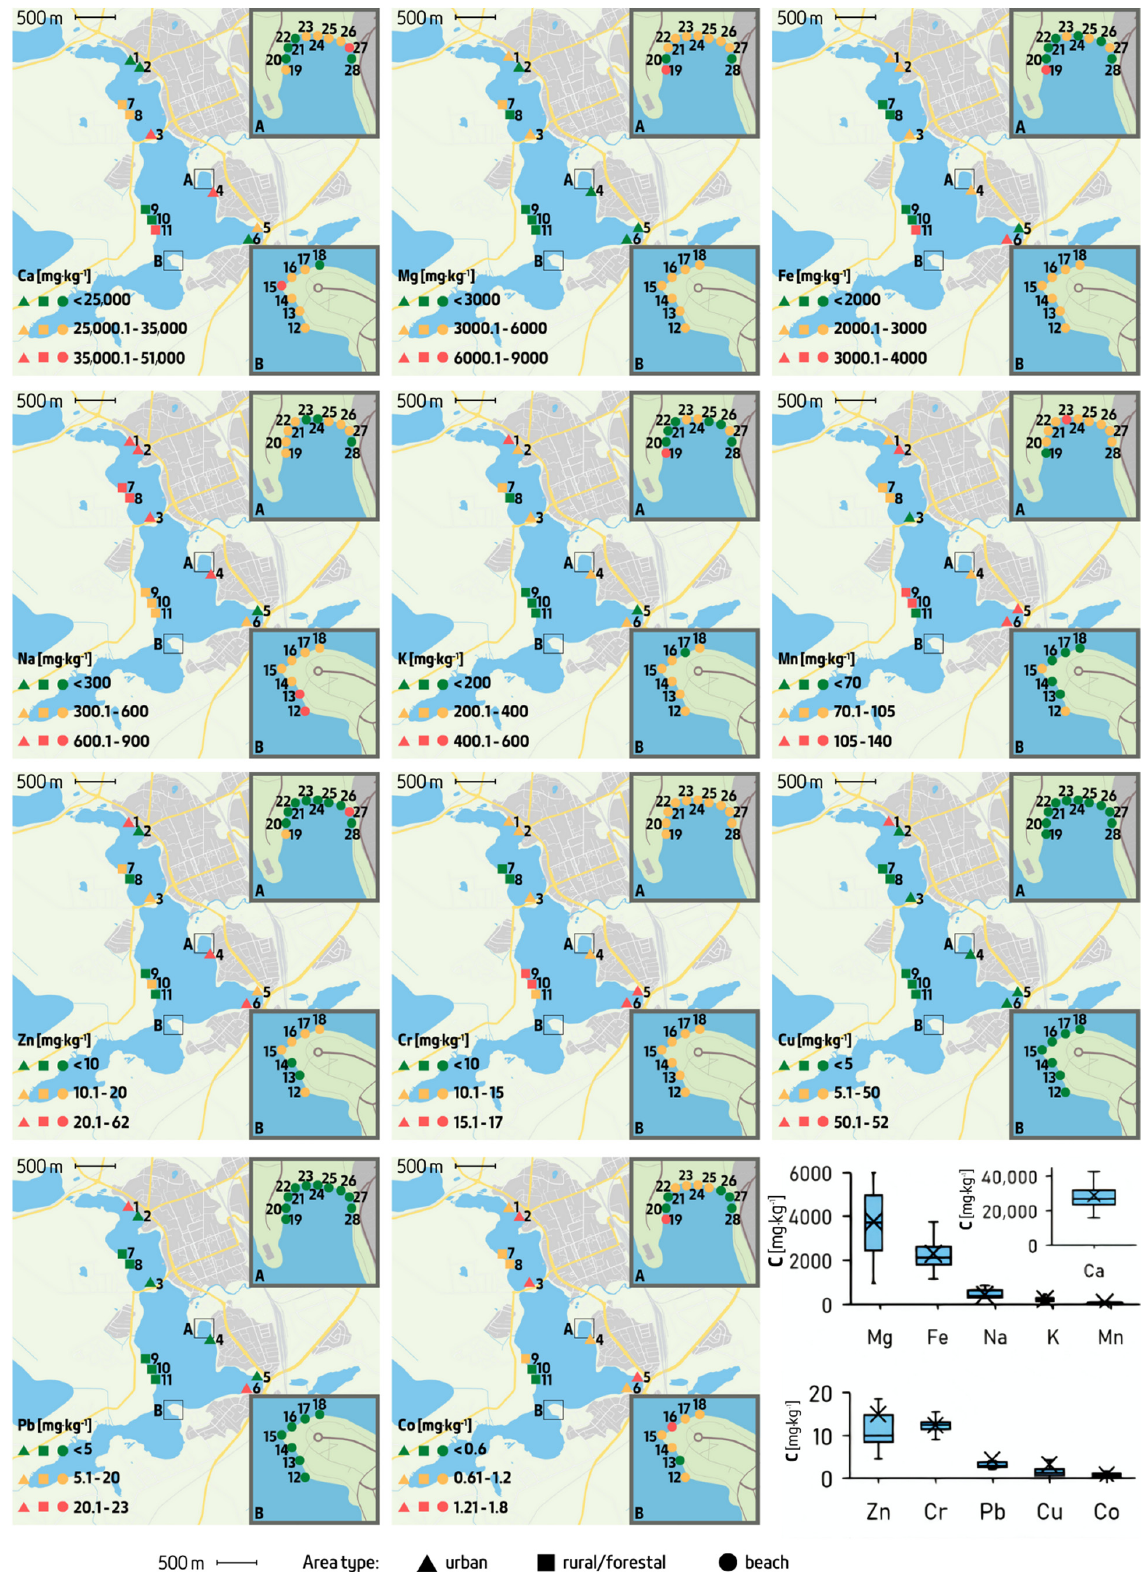
Figure 3. Spatial distribution of the analyzed metals (letter C on charts in the bottom right corner means concentration).